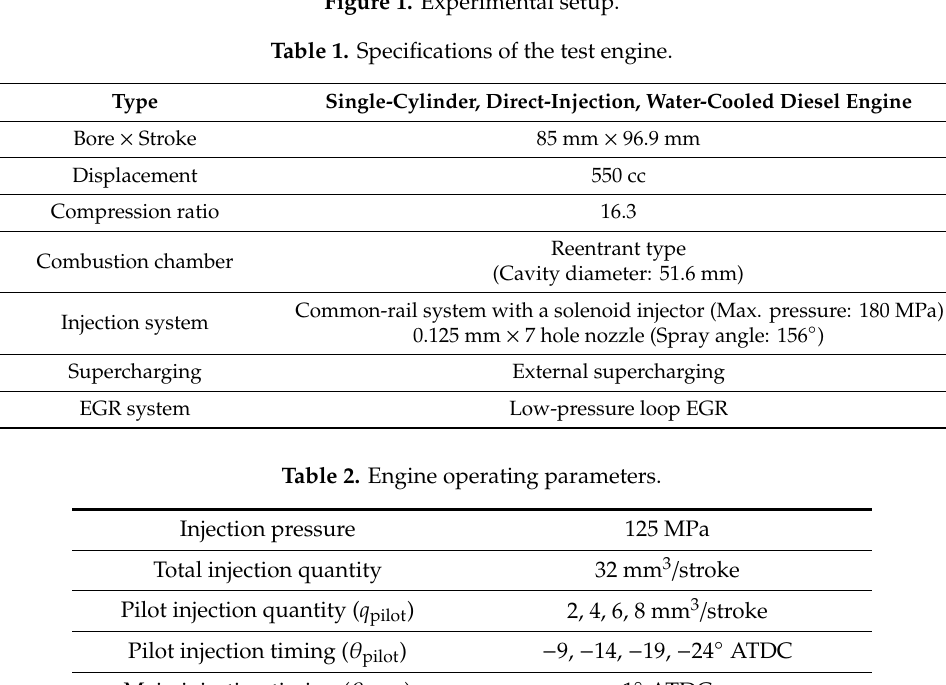
Table 2. Engine operating parameters.